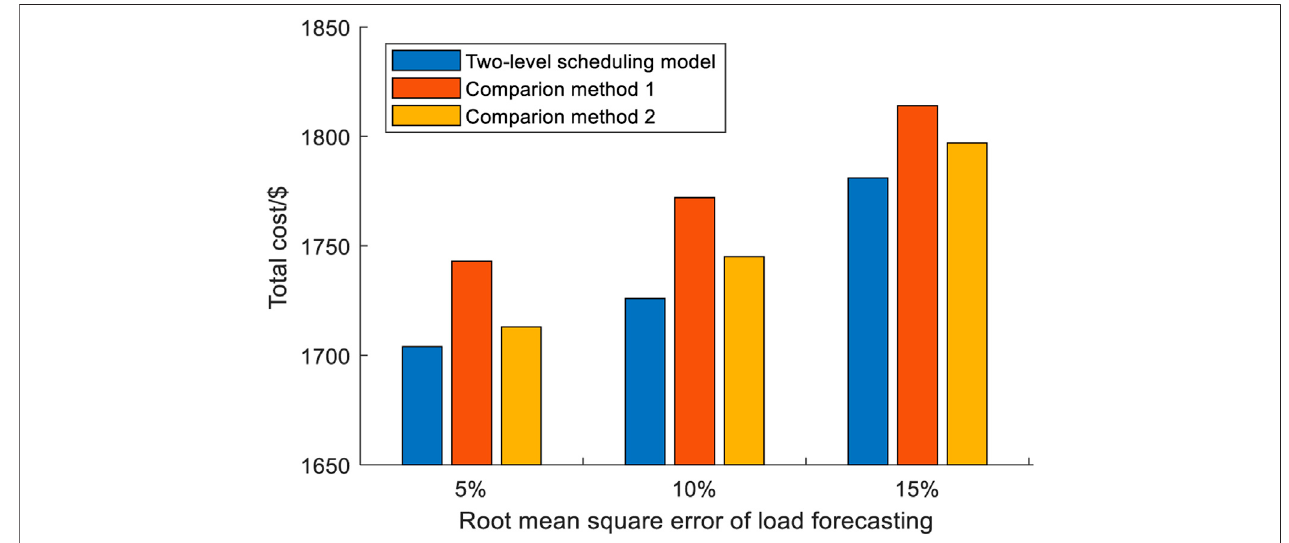
FIGURE 10 | Comparison of optimized scheduling